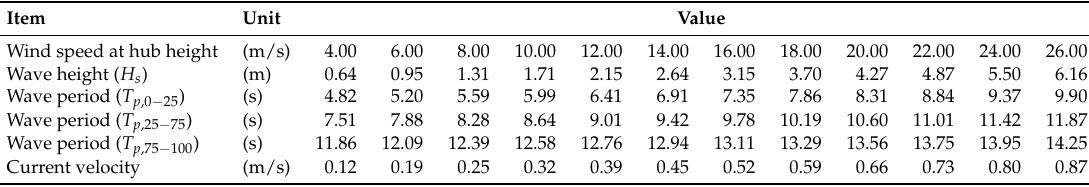
Table 2. Operational metocean conditions for fatigue limit state (FLS) calculations. Three peak wave periods are defined corresponding to the mean value of the probability sectors defined by the values in the